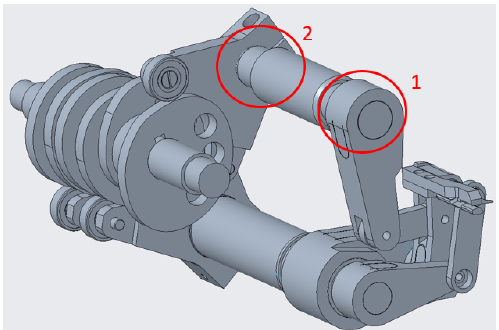
Figure 7. Locations where joint deformations are experimentally